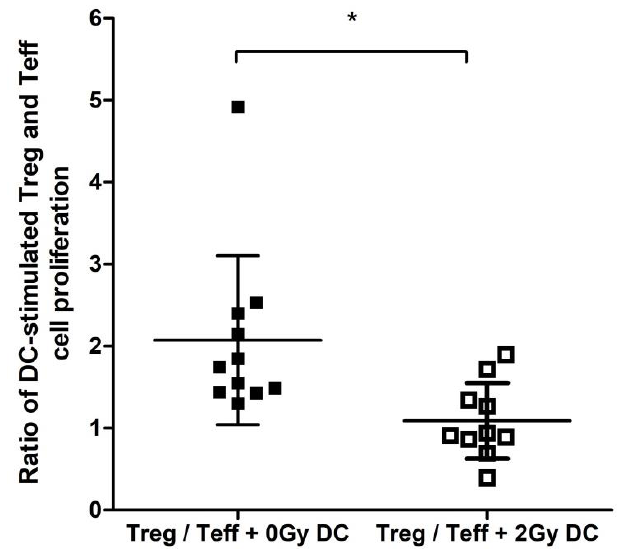
Figure 5. DC-induced proliferation of CD4 effector and regulatory T cells. Splenic DCs from irradiated and control mice as well as CD4+C25 − effector and CD4+CD25+ regulatory T cells from nonirradiated mice were isolated by magnetic cell sorting. DCs were in vitro cocultured with either effector T cells or regulatory T cells and T cell proliferation was evaluated by 3 H-thymidine incorporation. The figure shows the ratio of cell proliferation between regulatory and effector T cells cocultured with DCs from either control or irradiated mice. Data represent the average of 3 independent experiments with DCs isolated from 2 – 4 independent mice/experiment, with bars indicating mean ± SD. Significance was tested by Student’s t -test with * p < 0.005.